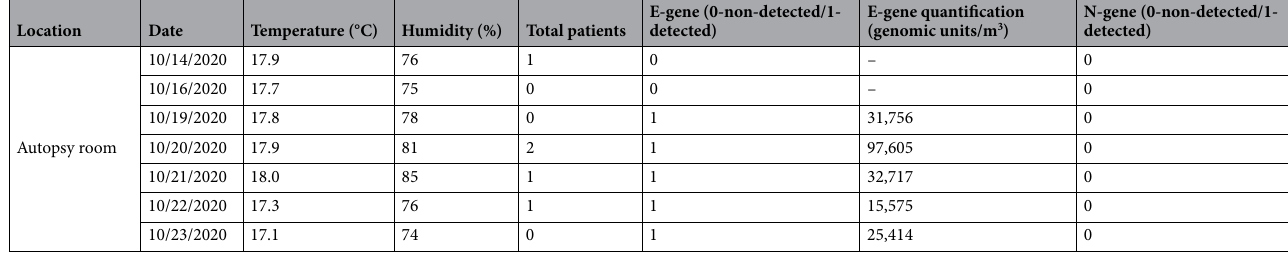
Table 3. Descriptive data of the necropsy room.